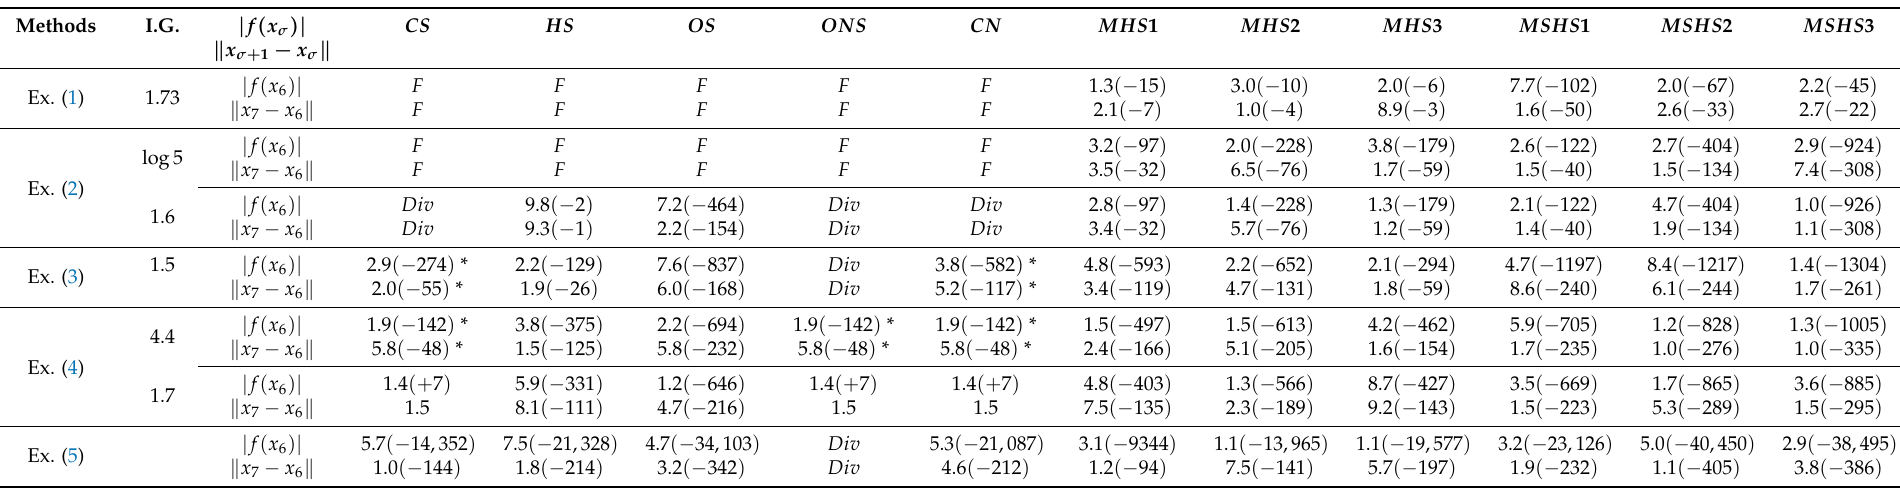
Table 1. Comparison of distinct iterative functions based on absolute residual errors and absolute difference between two consecutive iterations. * stands for convergence to undesired